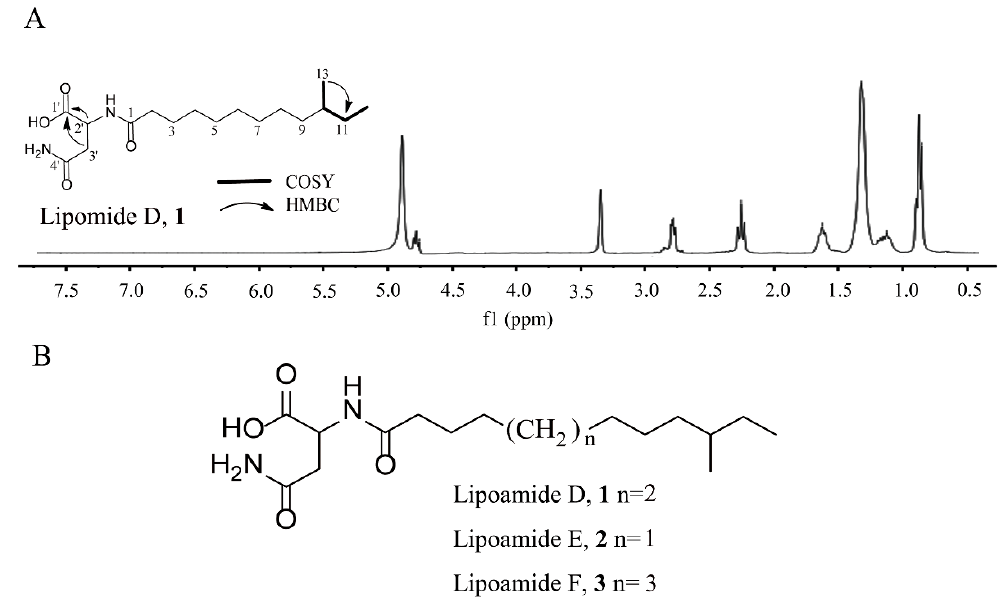
Figure 1. ( A ) 1 H NMR analysis, key 1 H– 1 H COSY, HMBC correlations, and ( B ) structure of lipomide D–F, 1 – 3 .